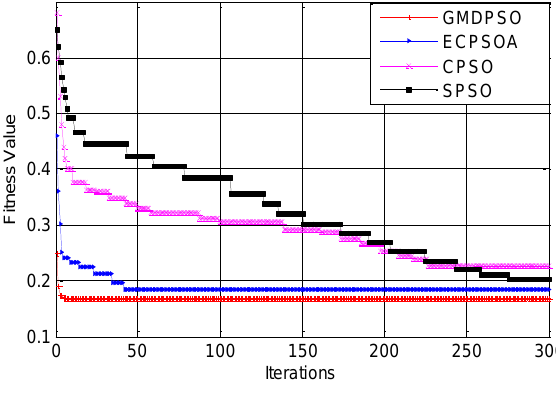
Figure 6. Compare of convergence.